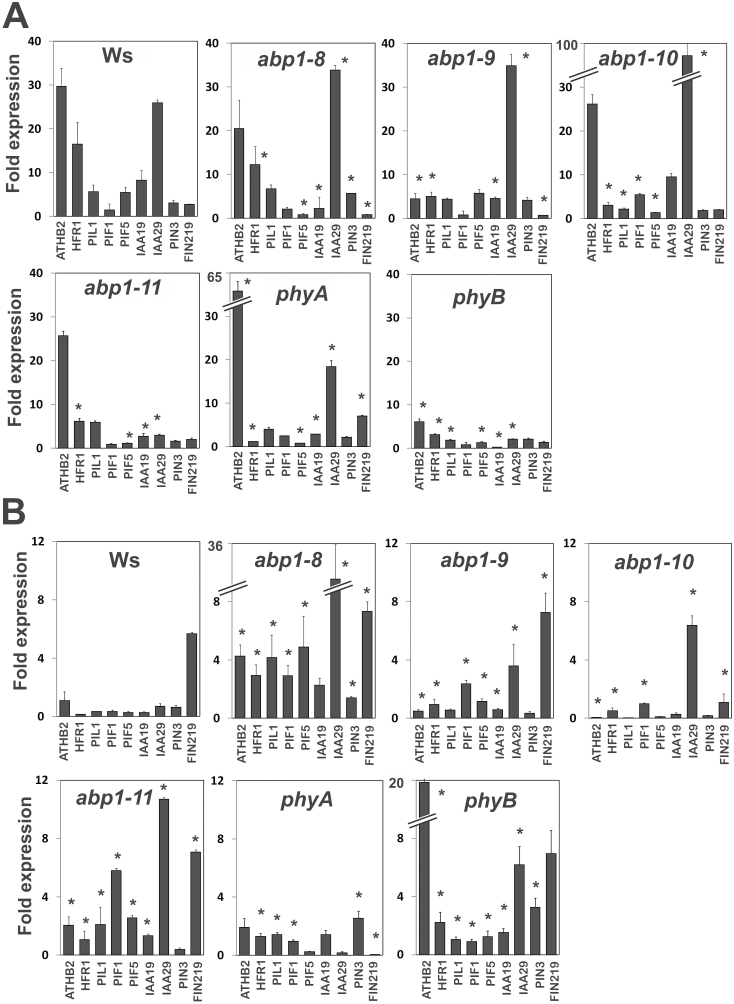
Expression response of shade-induced genes to 1h (A) low ratio R:FR (FR-enriched light) or (B) high ratio R:FR (R-enriched light). Seedlings were grown for 3 d in white light. qPCR data were obtained from at least three biological replications with three technical replications for each gene target. Statistical analysis was as described (Livak and Schmittgen, 2001; Pfaffl et al., 2002). At t=0min fold expression was set as 1 for each genotype (not on the graph). Values are means with SEM (* P<0.05).